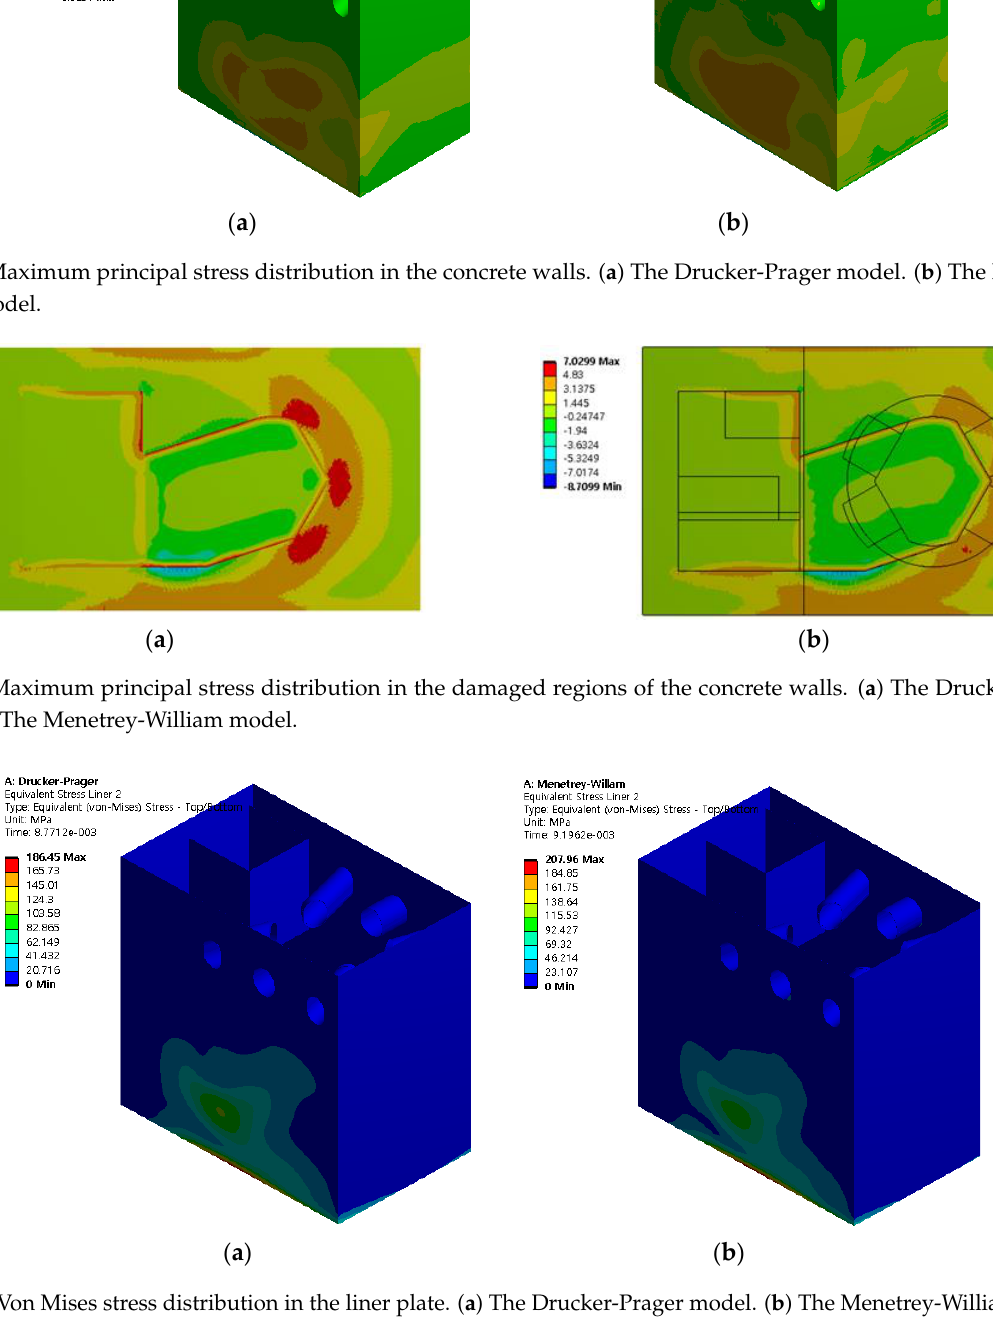
Figure 10. Von Mises stress distribution in the liner plate. ( a ) The Drucker-Prager model. ( b ) The Menetrey-William model.